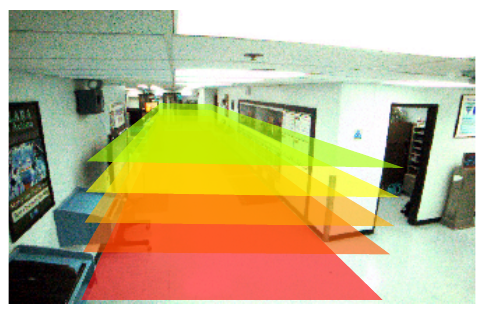
Figure 4. Anthropometric Planes: A new trajectory space for tracking joints of multiple